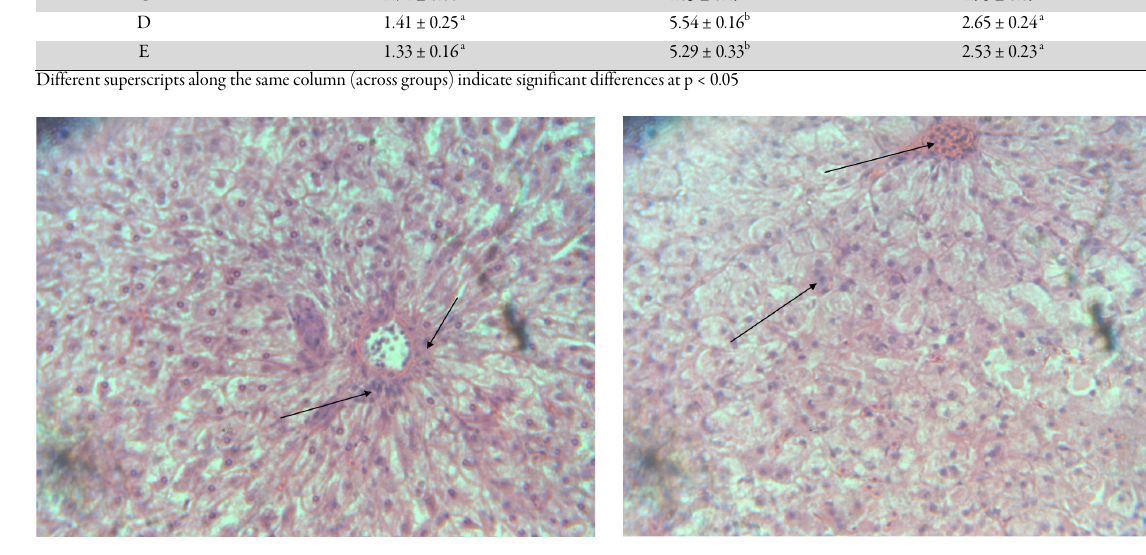
Fig. 1. Group A H&E X400 LIVER showing mild localized periportal infiltration by inflammatory cells (arrows)